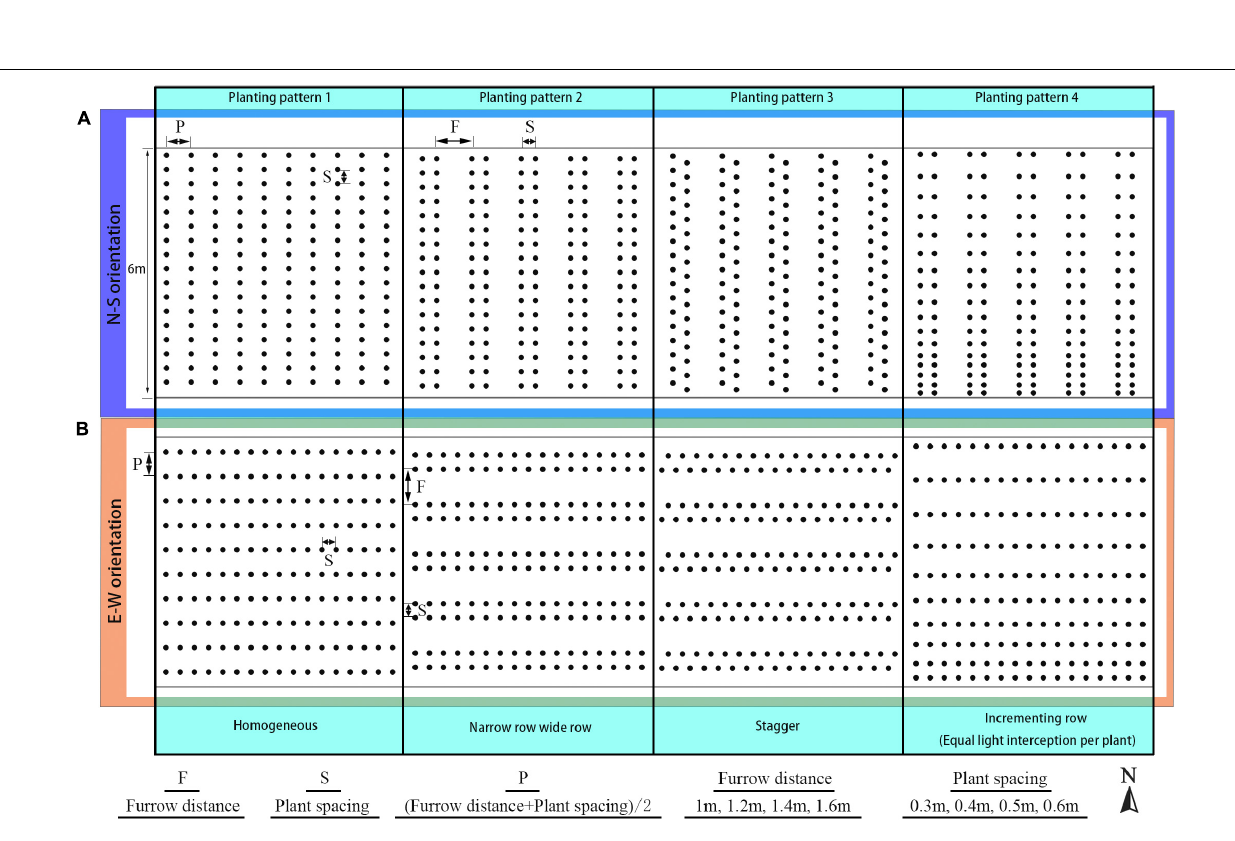
Frontiers in Plant Science | www.frontiersin.org 3 February 2022 | Volume 13 | Article